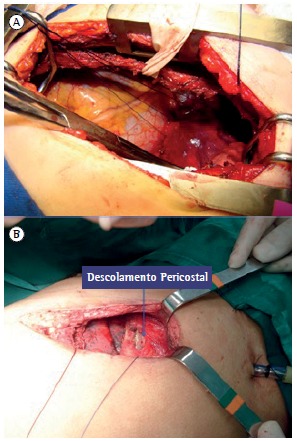
Em A, retalho intercostal laçado por dreno de Penrose. Em B,
descolamento do periósteo.